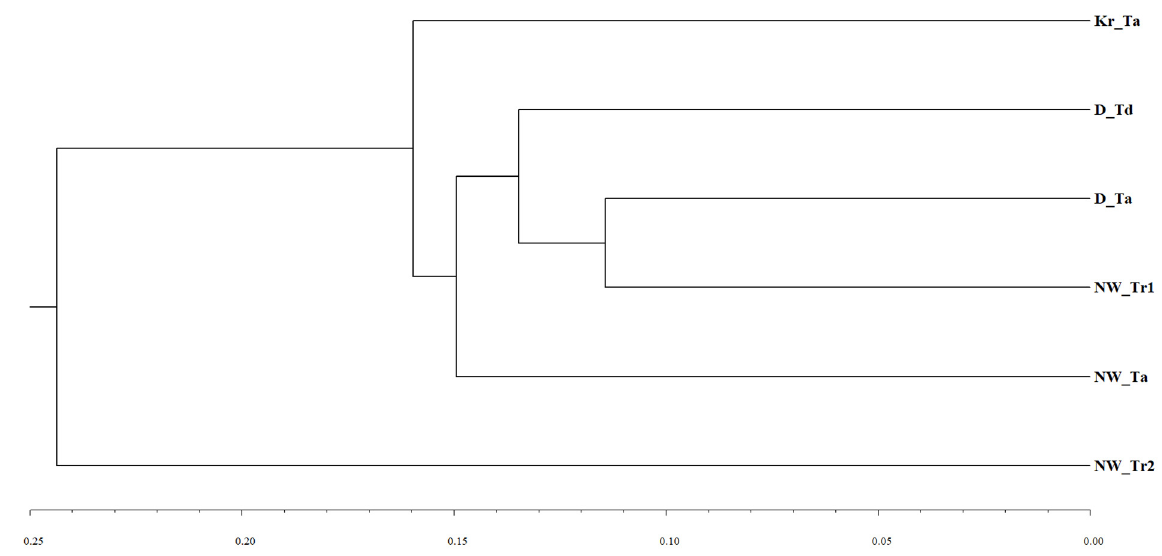
Figure 3. UPGMA dendrogram of relationships among P. striiformis collections of pathotypes from different hosts and regions based on the KB distance with regard to the simple mismatch dissimilarity between collections. Abbreviations of regions and host species: D—Dagestan, Kr—Krasnodar, NW—Noth-West; Ta— T. aestivum , Td— T. durum , Tr1 and Tr2—two groups of triticale (see Figure 2). For example, designation Kr_Ta means that this collection is from T. aestivum in the Krasnodar region; designation NW_Tr2 means that this collection is from the second group of triticale Tr2 in the North-West region.